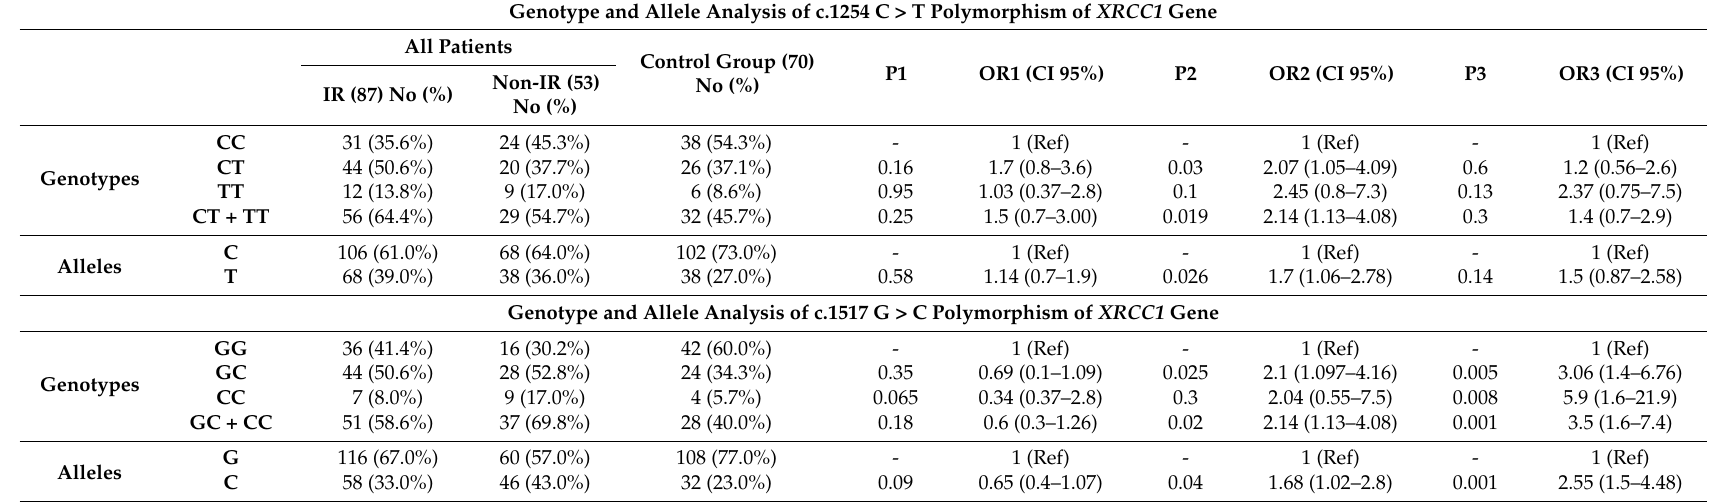
Table 2. Genotype and allele analysis of XRCC1 gene in IR, Non-IR and control